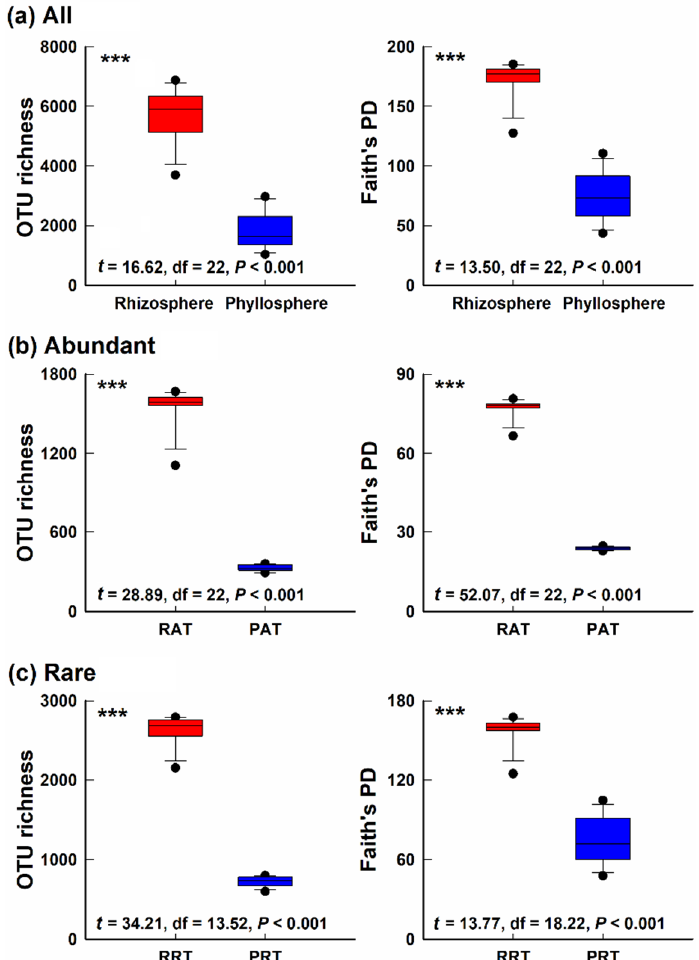
Figure 1. Comparisons of operating taxonomic units (OTU) richness and Faith’s phylogenetic diversity (PD) of bacterial communities in di ff erent epiphytic compartments of Phragmitas australis . ( a ) All, whole bacteria taxa; ( b ) Abundant, abundant bacteria taxa; ( c ) Rare, rare bacteria taxa. The top and bottom boundaries of each box indicate the third and first quartile values, respectively, and lines within each box represent the median values, whiskers show 95% range, and points are outliers. ***, indicates significant di ff erences among di ff erent groups ( p < 0.001, n = 12 for each group) according to two-tailed independent-sample t -test. RAT, rhizosphere abundant taxa; PAT, phyllosphere abundant taxa; RRT, rhizosphere rare taxa; PRT, phyllosphere rare taxa.